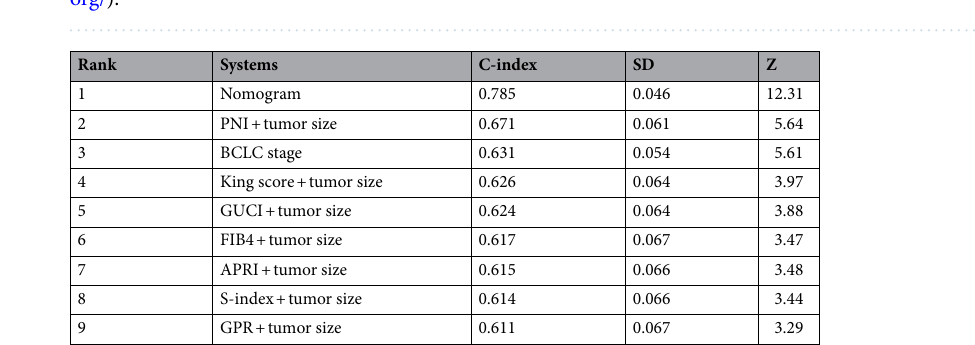
Figure 6. Time-dependent ROC curves for the OS in all samples’ cohort using the constructed nomogram, Barcelona Clinic Liver Cancer (BCLC) staging system and simple tumor size. The area under the curve (AUC) generated from their time-dependent ROC curves for predicting the OS at 1- (A) , 3- (B) , and 5-year (C) was presented. The figure was performed using R software (version 3.3.1, Vienna, Austria, https:// www.r- proje ct. org/).